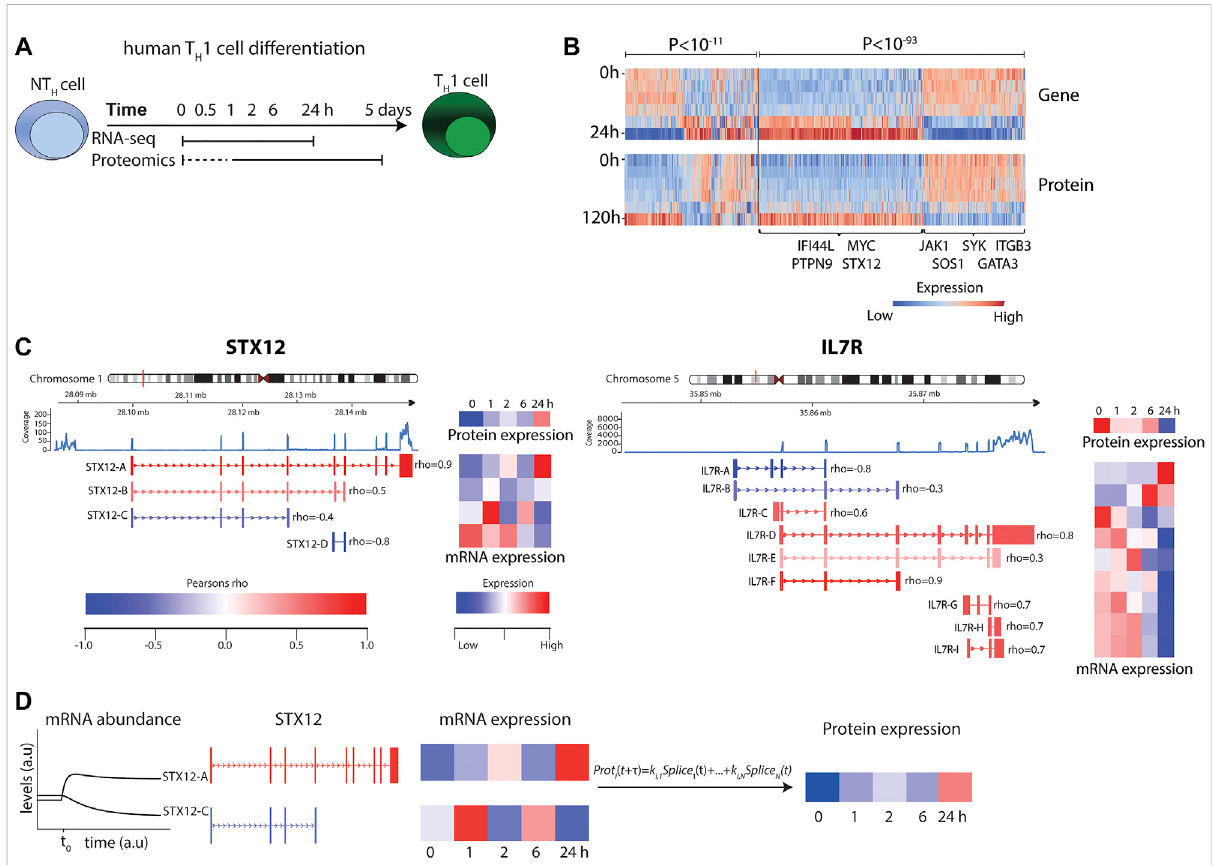
RNA-seq and mass-spectrometry analysis of T H 1 differentiation revealed highly variable correlations. (A) Experimental design. (B) Heat map of transcript and protein abundance dynamics in genes that show signi fi cant negative (left) and positive (right) correlations. Genes of particular relevanceforTcellsandTcelldifferentiationarehighlightedinthe fi gure. (C) Examplesoftranscriptsplicevariantsshowingthatboth STX12 (left)and IL7R (right)weresigni fi cantlynegativelyandpositivelycorrelatedwithproteinlevels. (D) Illustrationofthemodellingprocedureforresolvingthe poor correlation, using STX12 as an